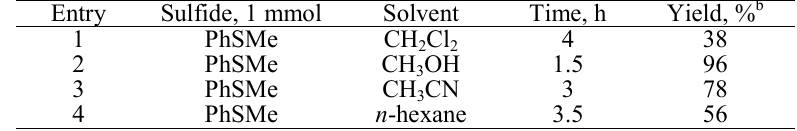
Table 1. Oxidation of methylphenyl sulfide to corresponding sulfoxide in different solvents a .